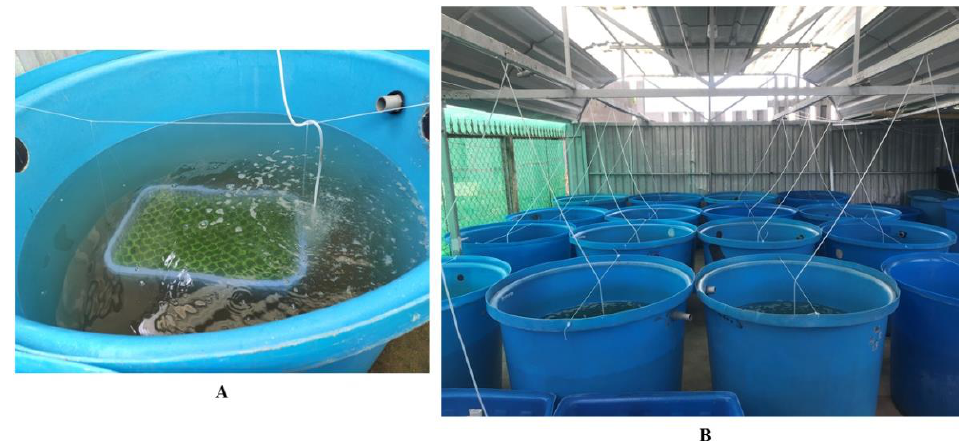
Figure 1. ( A ) Experimental tank design, showing the relative position and orientation of the sea grape culture tray in use; ( B ) experimental set-up with natural photoperiod.